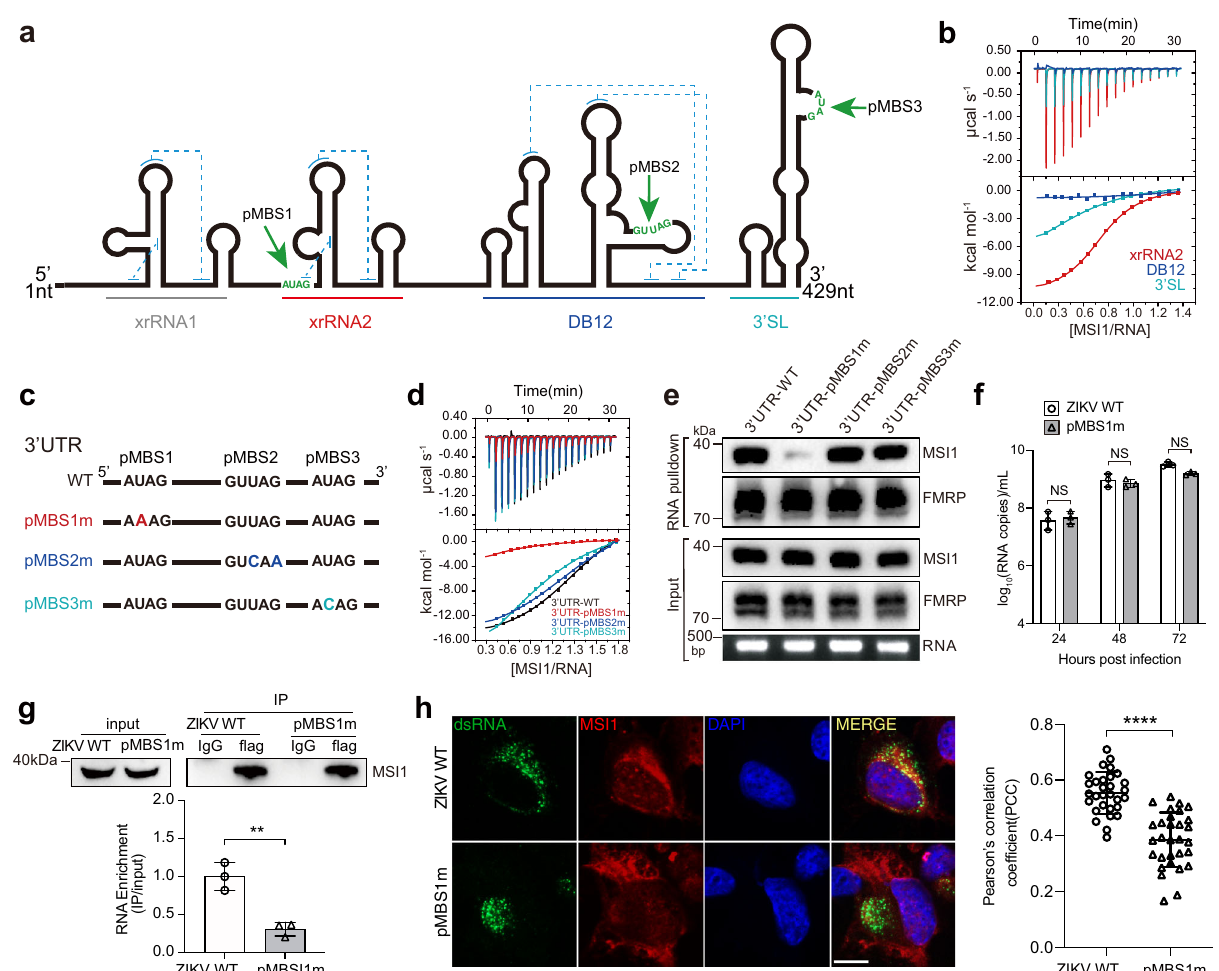
Fig. 1 | The pMBS1 in ZIKV xrRNA2 is responsible for MSI1 binding. a Putative MSI1 binding sites (pMBS) in the 3´ UTR of ZIKV. The pseudoknots are indicated withbluedashedlines. b TheITCpro fi lesofRRM12totheindividualxrRNA2,DB12, and 3´ SL sequences. c Schematic showing mutations in the putative MSI1 binding sites in the 3´ UTR of ZIKV. d The ITC pro fi les of RRM12 to the ZIKV 3´ UTR WT, pMBS1m, pMBS2m and pMBS3m. e RNA pull-down assays performed with the WT orsinglepMBSmutant(1-3)3 ′ UTRsofZIKV.InvitrotranscribedbiotinylatedRNAs were incubated with cell extracts of BHK-21 cells transfected with fl ag-MSI1, and RNA-protein complexes were captured on streptavidin beads. Representative Western blots probed with antibody against MSI1 are shown together with corre- sponding protein and RNA inputs. Similar result was repeated independently in 3 times. f ZIKV WT and pMBS1m viral RNA copies in culture supernatants of BHK-21 cells (MOI=0.1).Data are the mean±SD. n =3 independent experiments. Two-way ANOVA,NS,notsigni fi cant. g RNA-IPanalysisfromWTorpMBS1minfectedBHK-21